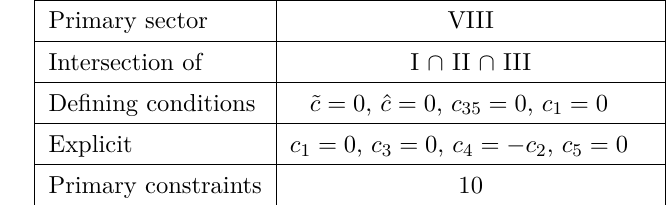
Table 3 . Defining condition and properties of the primary sector